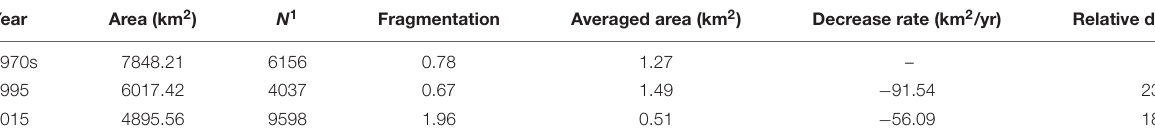
TABLE 4 | Total intertidal wetland conditions in the 1970s, 1995, and 2015.